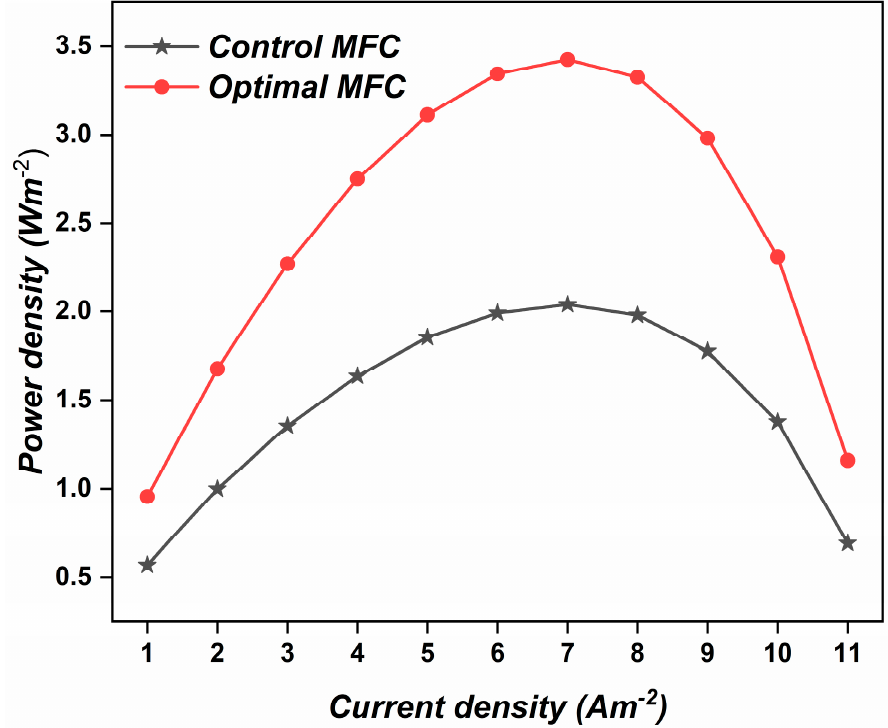
Figure 3. Comparative analysis of the control and the optimized MFCs.